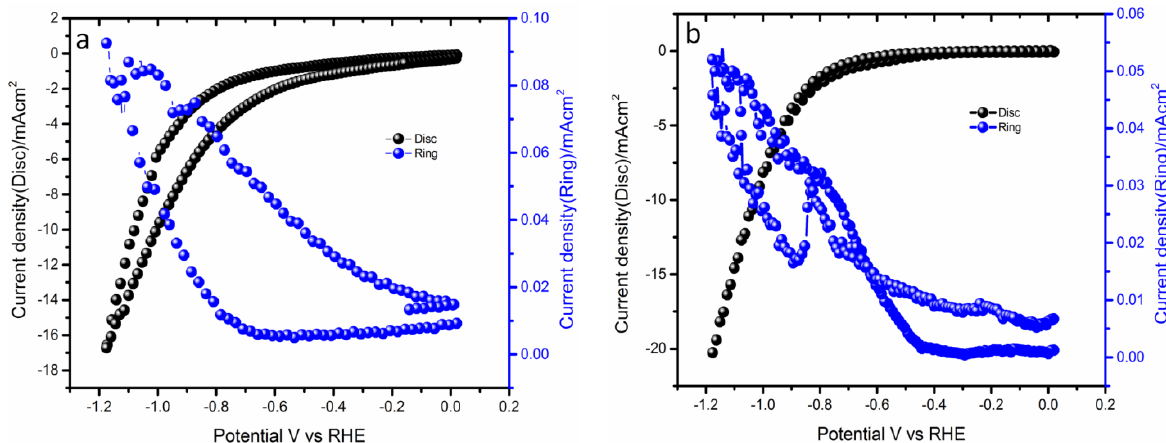
Figure 10. Cyclic voltammetry scans of CoAg / CN with RRDE. Disc electrode was scanned between 0 and − 1.2 V versus RHE, the ring electrode was held at 0.9 V versus RHE. ( a ) Initial CV scan for N 2 purged electrolyte. Ring electrode was held at 0.9 V versus RHE. ( b ) CV scan for the system after CO 2 saturation with the ring held at 0.9 V versus RHE. The experiments were all performed at room temperature. Scan rate: 100 mV s − 1 . Constant rotation (1500 rpm) was used.